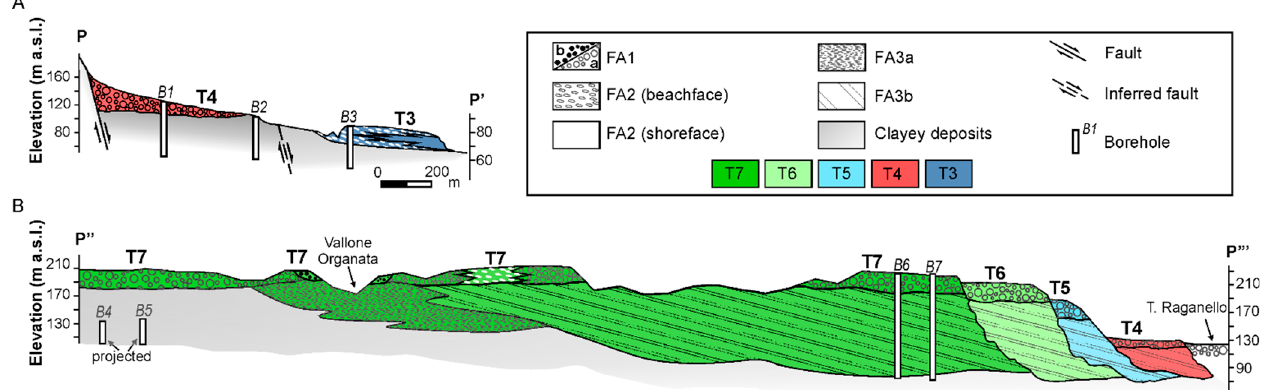
Figure 5. Morphostratigraphic sections showing the relationships among the clastic successions of terraces. ( A ) View of T4 and T3, on the left side of Vallone Organata. Alluvial conglomerates show an eastward decrease in thickness and taper on clayey sediments near the outer T4 edge. A clastic transgressive–regressive sequence is noteworthy on the T3 terrace. ( B ) Lateral and vertical variations in facies association are well noticeable on the T7 terrace where Gilbert-deposits (FA3b) pass laterally to shoal-water delta sediments (FA3a) and are overlain by fluvial conglomerates and locally by shallow marine deposits. For each FA, the color refers to different orders of terraced deposits. See Figure 2 for profile and borehole location.